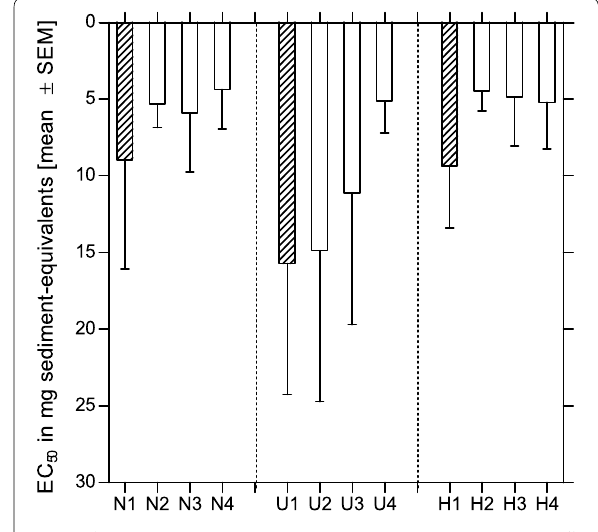
Fig. 4 Microtox assay. Mean and standard error of the mean of EC 50 values (in mg sediment equivalents) for baseline toxicity of sediment samples from the rivers Nidda, Usa and Horloff. Reference sites N1, U1 and H1 are shaded. n 6 with 8 pseudo‑replicates =